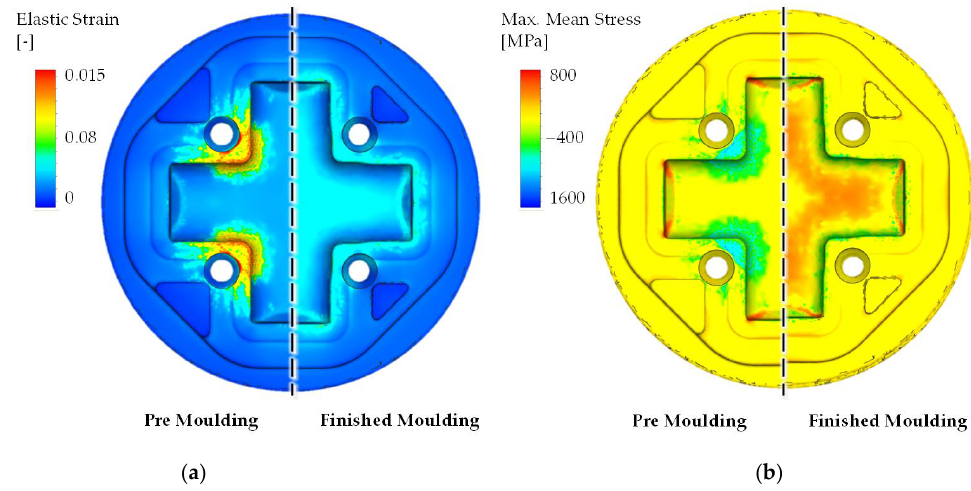
Figure 15. ( a ) Elastic strain and ( b ) Maximum mean stress distribution of both forming stages.